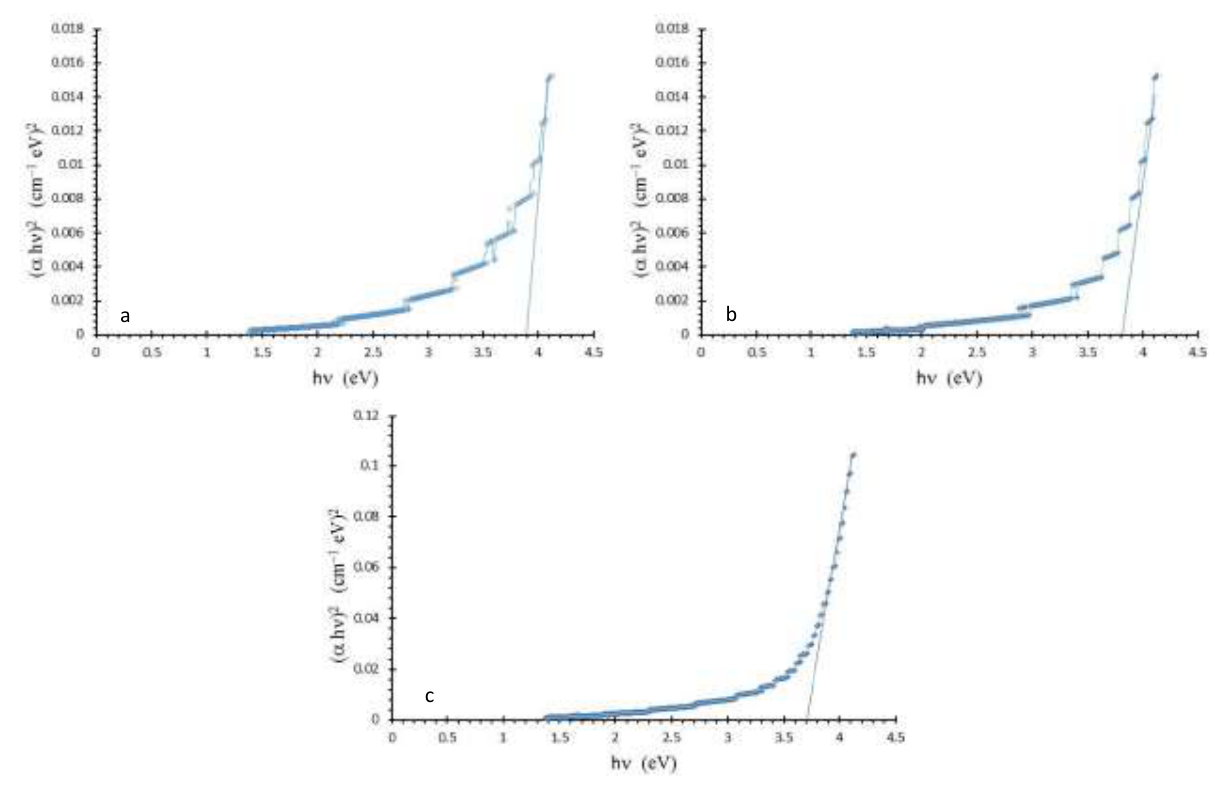
Figure 4: The optical band gap of TiO 2 NPs prepared at different laser energy (a) 80mJ (b) 120mJ, and (c)